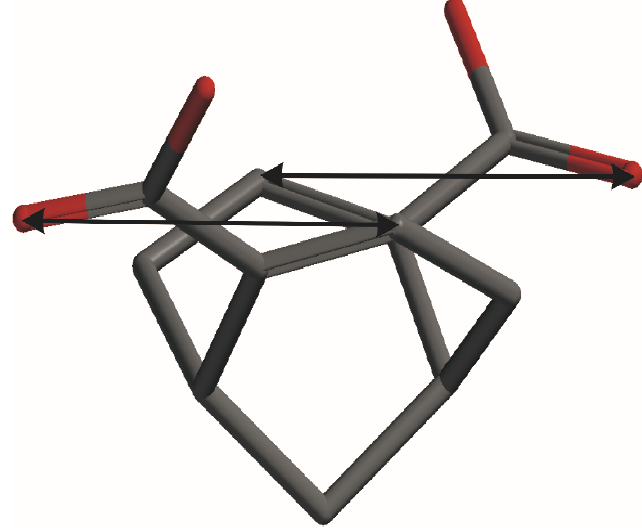
Figure 2. Orientation of the two long-axis polarized π→π * transition dipoles in 4 .